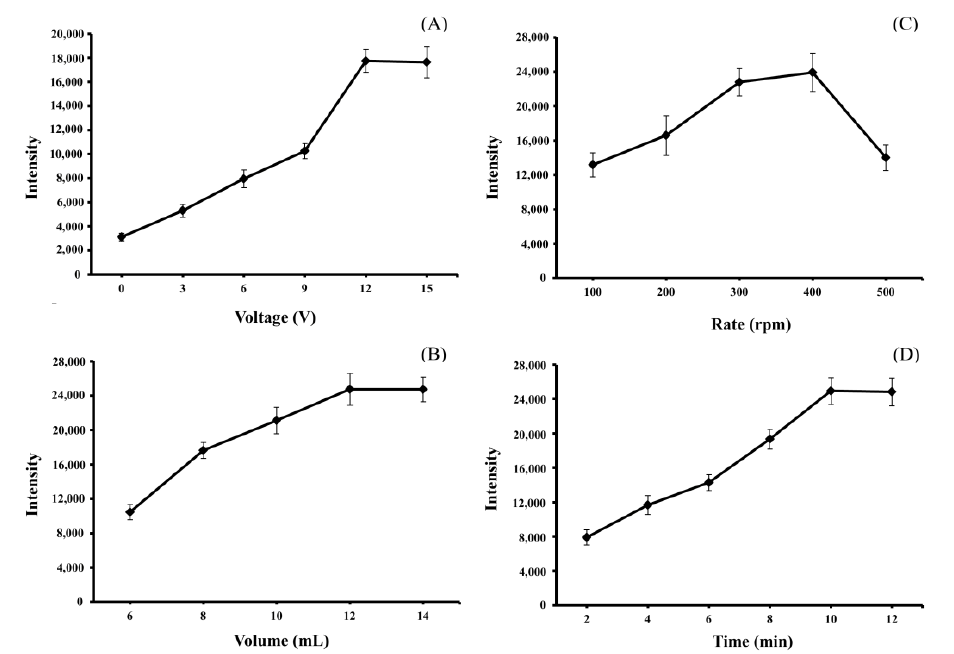
Figure 6. Effect of ( A ) the applied voltage, ( B ) the sample volume, ( C ) the agitation rate, and ( D ) the extraction time on the signal intensity of insulin obtained from the EME. Experimental conditions: insulin concentration, 50.0 nM. All other conditions were identical to those outlined in Figure